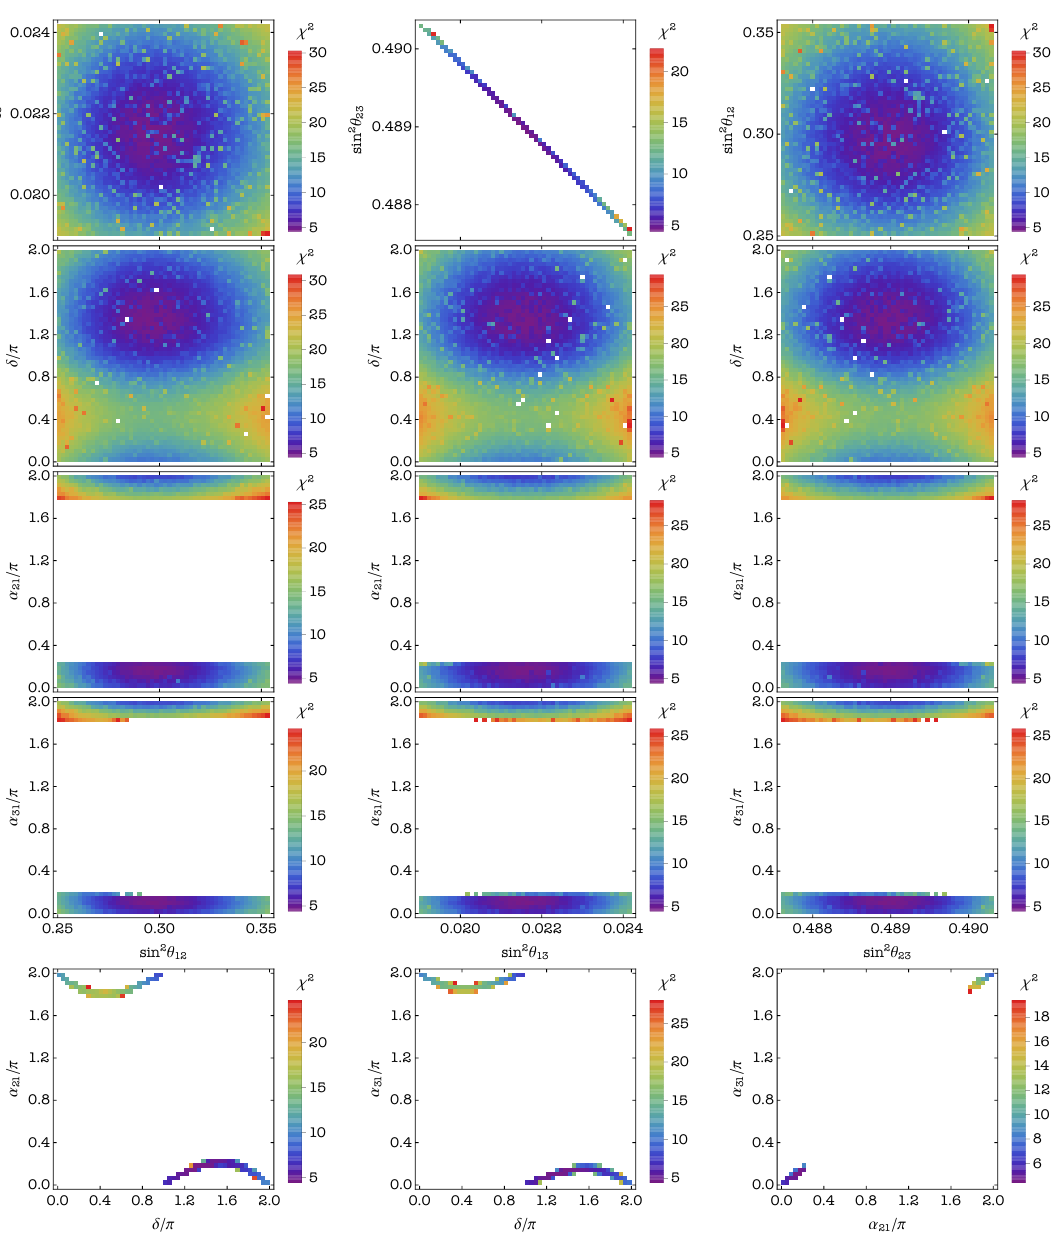
Figure 4 . Correlations between the neutrino mixing parameters in case B4. The values of all the three mixing angles are required to lie in their respective 3 (cid:27) ranges. Colour represents values of (cid:31) 2 for the IO neutrino mass spectrum. Note that this case is not compatible with the 2 (cid:27) range of sin 2 (cid:18) 23 .